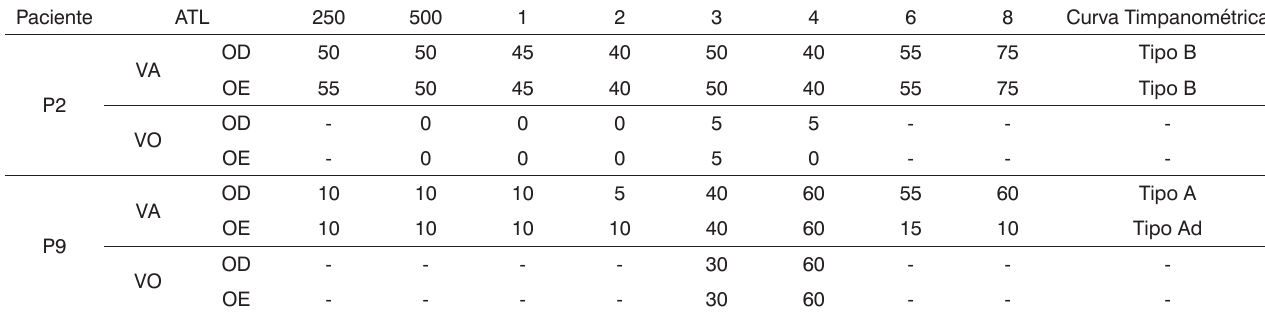
Tabela 2. Ocorrência de perda auditiva nos pacientes com G/BBB.